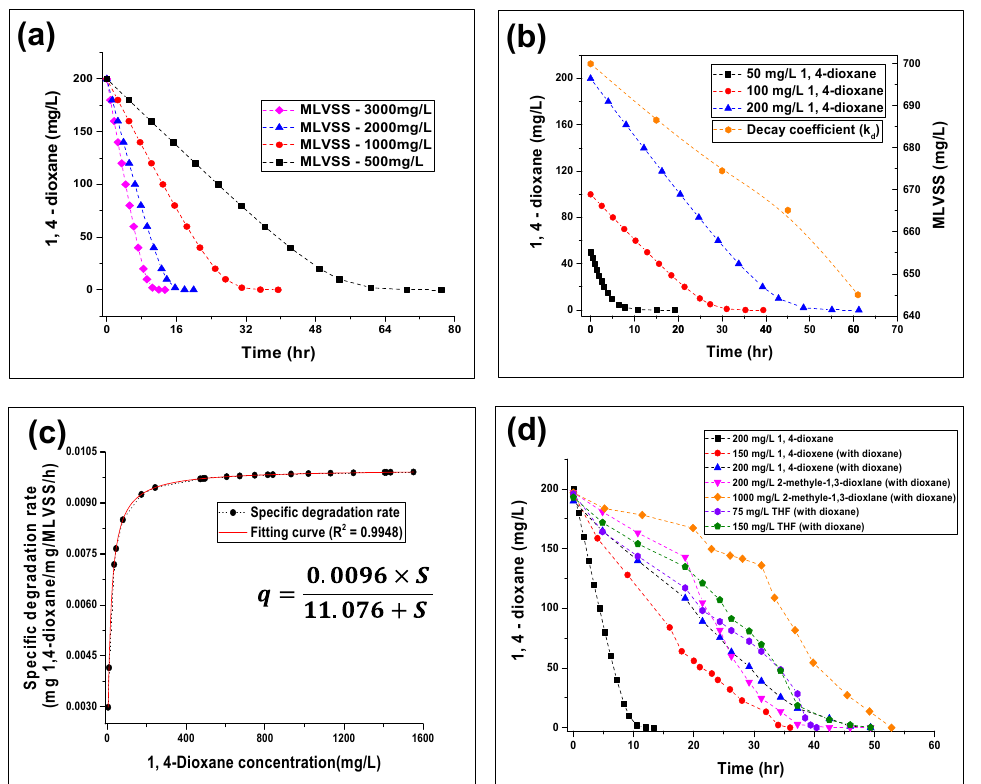
Figure 3. Batch test analysis for 1,4-dioxane degradation: ( a ) impact of the variation of MLVSS on the biodegradation of 200 mg/L of 1,4-dioxane; ( b ) variation in the biodegradation of 1,4-dioxane at a fixed MLVSS level of 700 mg/L for biotic control for determination of the decay rate; ( c ) Monod plots of various kinetic parameters determined at various initial concentrations; and ( d ) impact of a competitive inhibitor on the biodegradation of